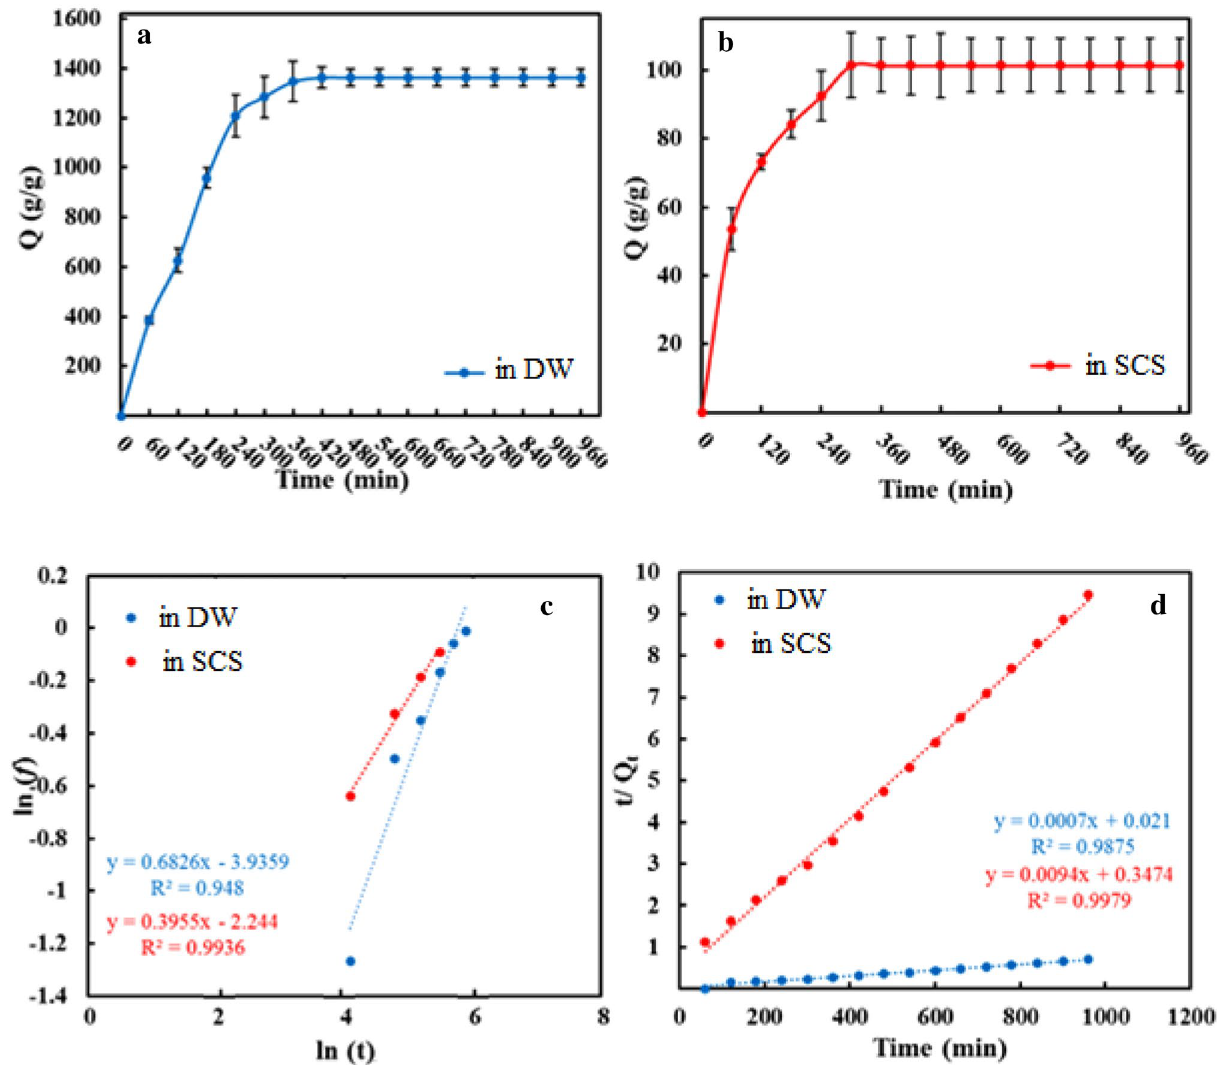
Figure 5. Swelling kinetics of p(AA-co-AM-co-MA) superabsorbent ( a , b ). Two classic kinetic theories models are studied ( c ) The ln t dependence of ln f and ( d ) relationships of t/Q t with t for p(AA-co-AM-co-MA)